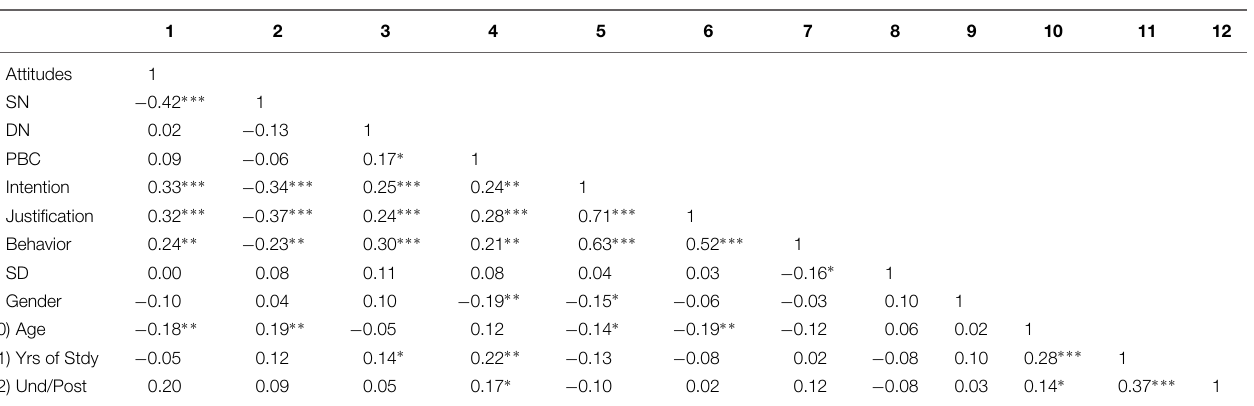
TABLE 3 | Pearson’s correlations between model and control variables.